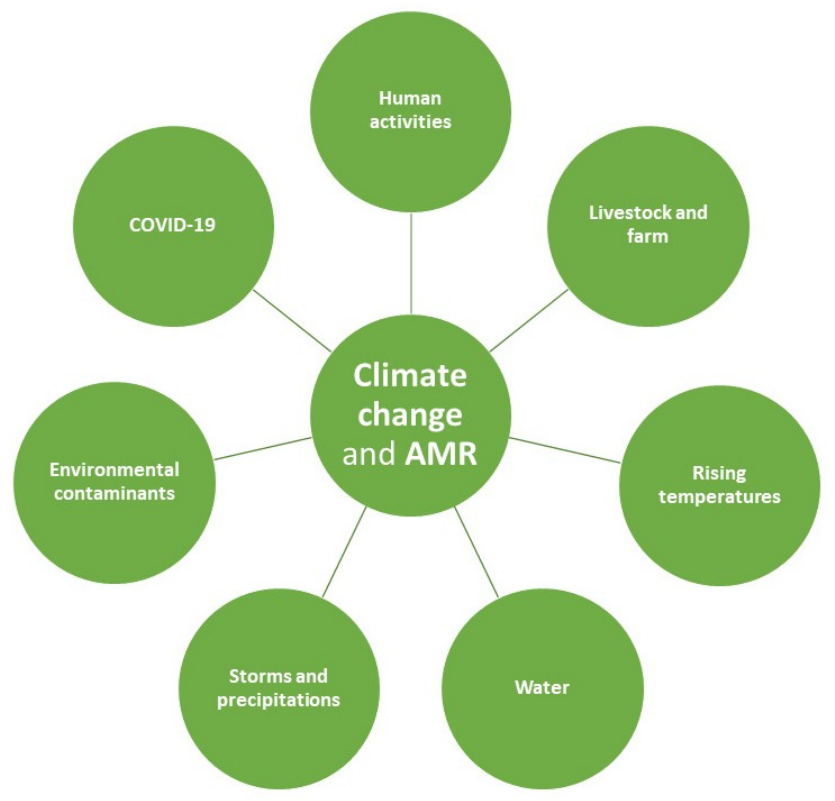
Figure 1. The main factors involved in the relationship between climate change and antimicrobial resistance. Abbreviation: AMR, Antimicrobial Resistance .